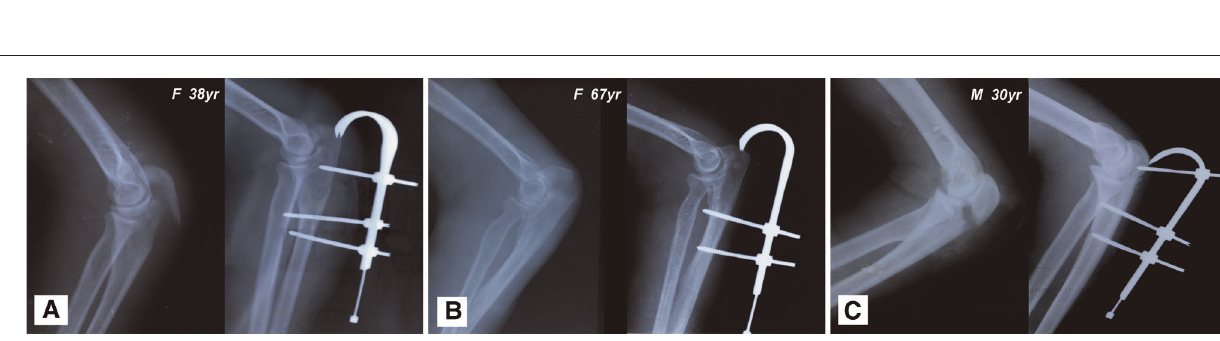
FIGURE 3 | Comparative study of perioperative clinical data between TBW and J-EF treatment. A comparative study of perioperative data including operative time ( A ) and intraoperative blood loss ( B ) between J-EF and TBW was performed according to the anesthesia sheets and suction device; the percentage represents the reduction in the J-EF group relative to the TBW